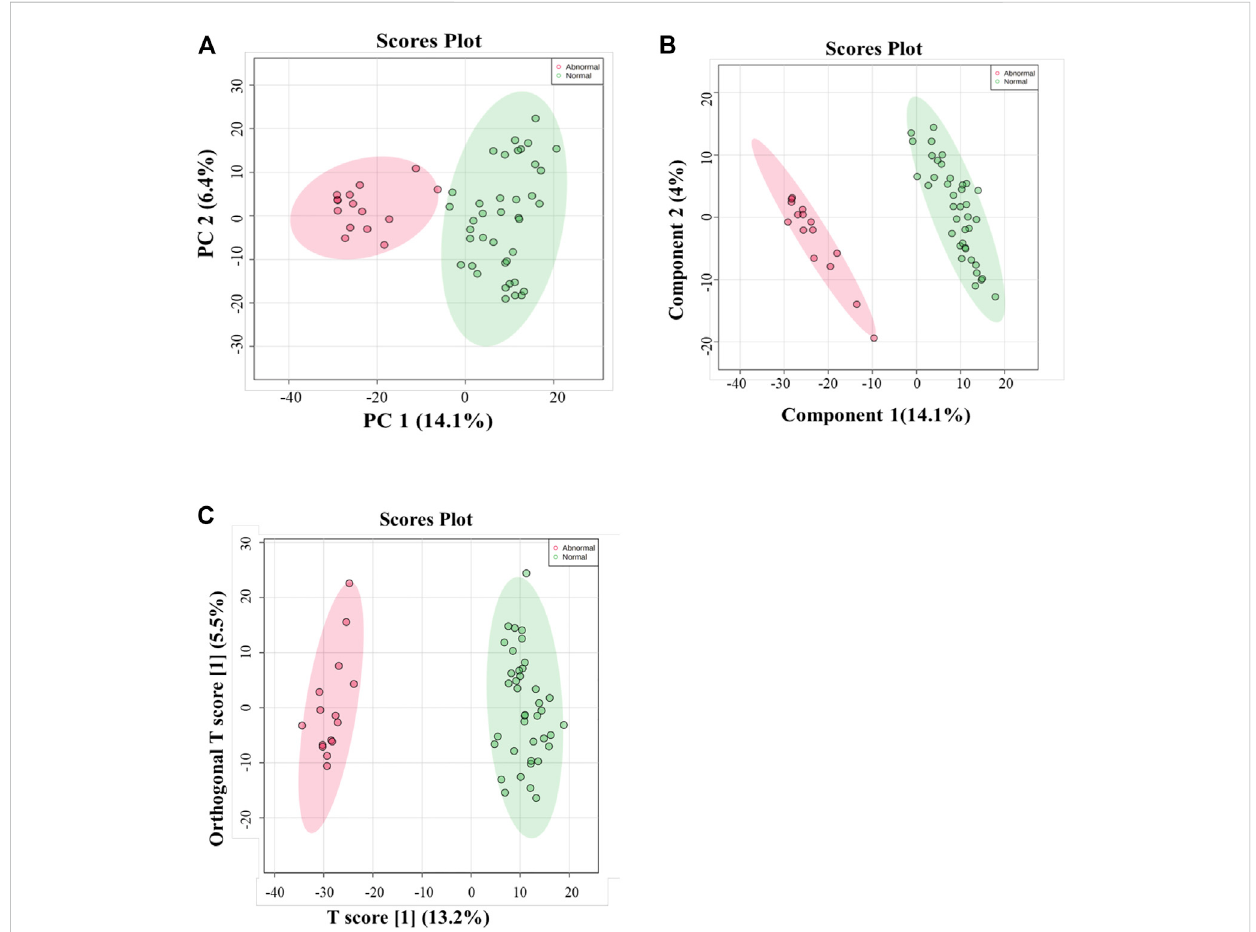
FIGURE 1 (A) Principalcomponent analysis (PCA)modelfor54samplesobtained from15GAL patientsand 39controlthat showedaclearseparation between the two groups (GAL patients and healthy control). (B) PLS-DA Score Plots revealed a clear separation between the groups (GAL patients and healthy control). (C) Orthogonal partial least squares-discriminant analysis (OPLS-DA) score plot showed evident separation between two groups (GAL patients and healthy control). The robustness of the created models was evaluated by the fi tness of the model (R2Y = 0.972) and predictive ability (Q2 = 0.856)